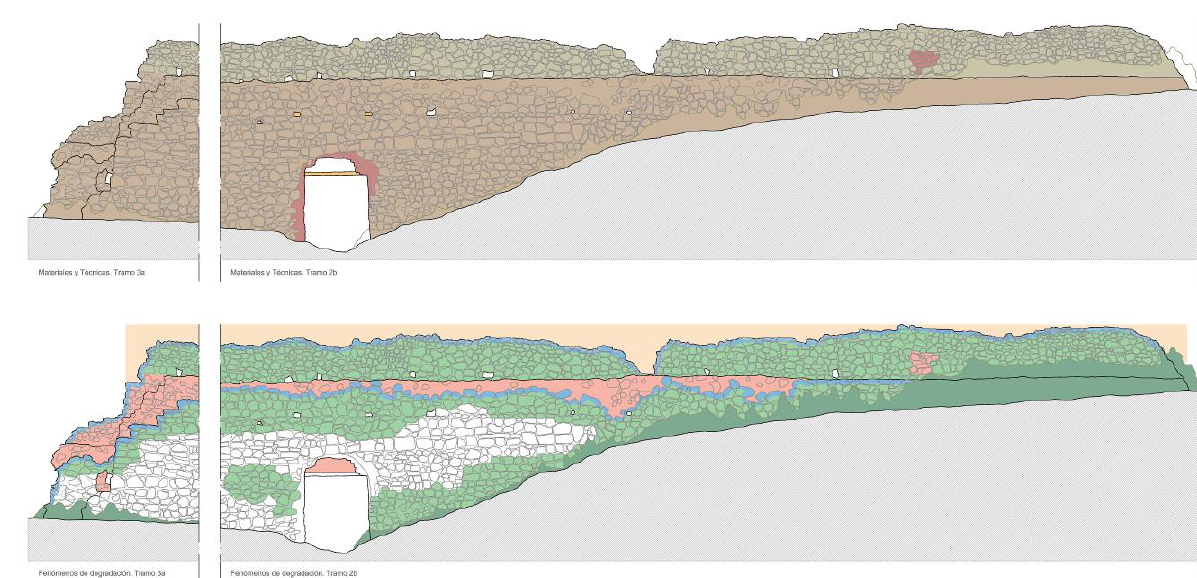
Figure 6. Study of the used constructive techniques and existing decay processes in the section of the wall containing the southern wicket-gate (Díaz and Baró,